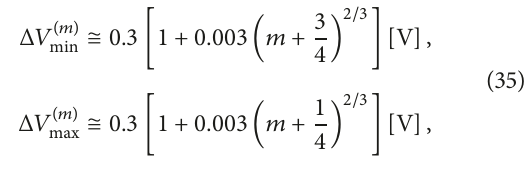
Figure 6: The average current as a function of the oscillation’s amplitude for different oscillation’s frequencies (same numerical parameters as in Figure 3).